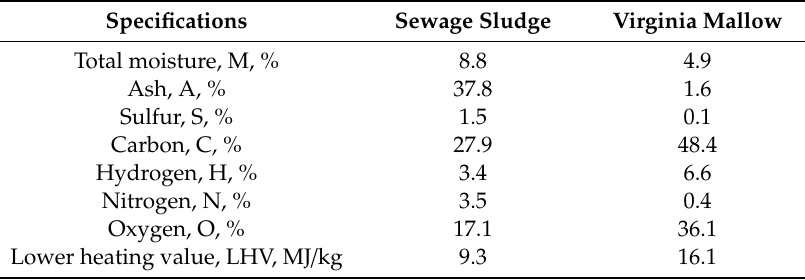
Table 1. Results of ultimate and proximate analysis of dry sewage sludge and Virginia Mallow. Specifications